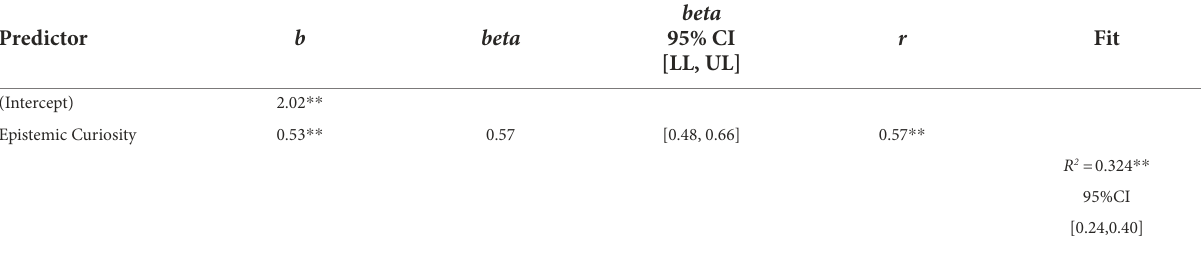
TABLE 6 Regression results using entrepreneurial alertness as the criterion.